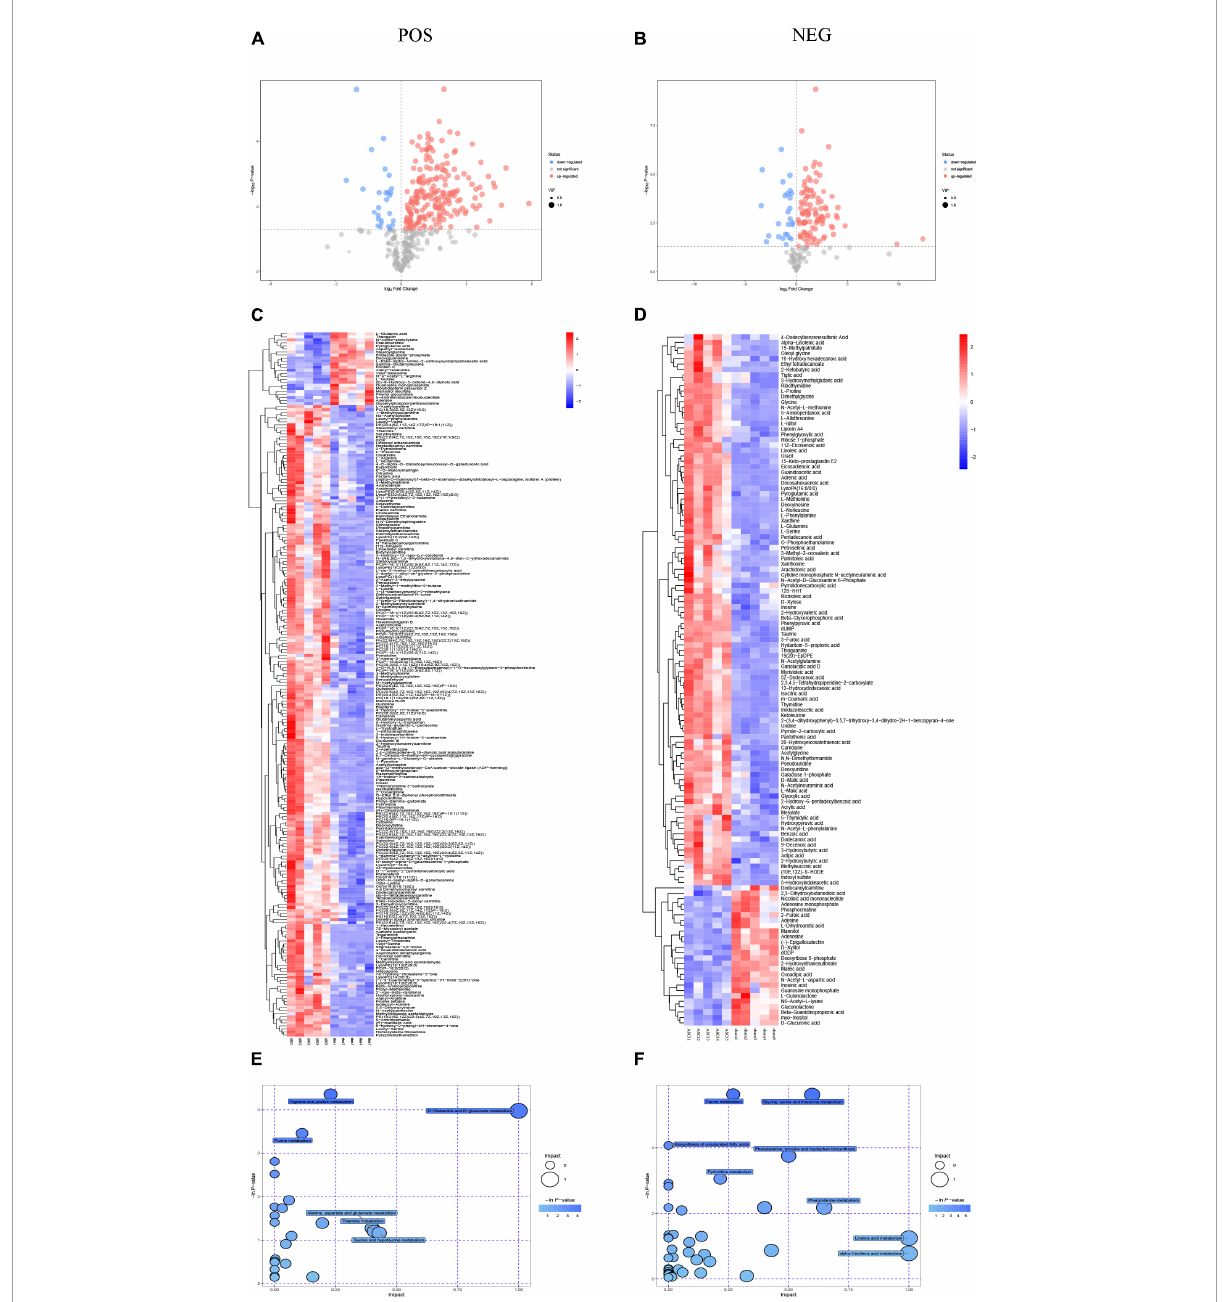
FIGURE3 Metabolomic results for group sham vs. the acute-phase spinal cord injury in both positive ion mode and negative ion mode. (A,B) Volcano plot in both positive ion mode and negative ion mode. Each dot represents a metabolite, with significantly upregulated metabolites are indicated in red, significantly down-regulated metabolites are indicated in blue, and non-significantly different metabolites are in gray based on variable importance in the projection > 1 and P < 0.05. (C,D) Heatmap of hierarchical clustering analysis in both positive ion mode and negative ion mode. The horizontal axis represents different experimental groups, the vertical axis represents the differential metabolites compared in that group, the color blocks at different positions represent the relative expression of metabolites in the corresponding position, red color indicates that the substance is highly expressed in the group, blue color indicates that the substance is lowly expressed in the group. (E,F) Pathway analysis in both positive ion mode and negative ion mode. Each bubble in the bubble diagram represents a metabolic pathway, the horizontal axis where the bubble is located and the bubble size indicate the size of the influence factor of that pathway in the analysis, and the vertical axis where the bubble is located and the bubble color indicate the P -value of the enrichment analysis (taking the negative natural logarithm, namely − ln(p)). POS: positive ion mode; NEG, negative ion mode; ASCI, the acute-phase spinal cord